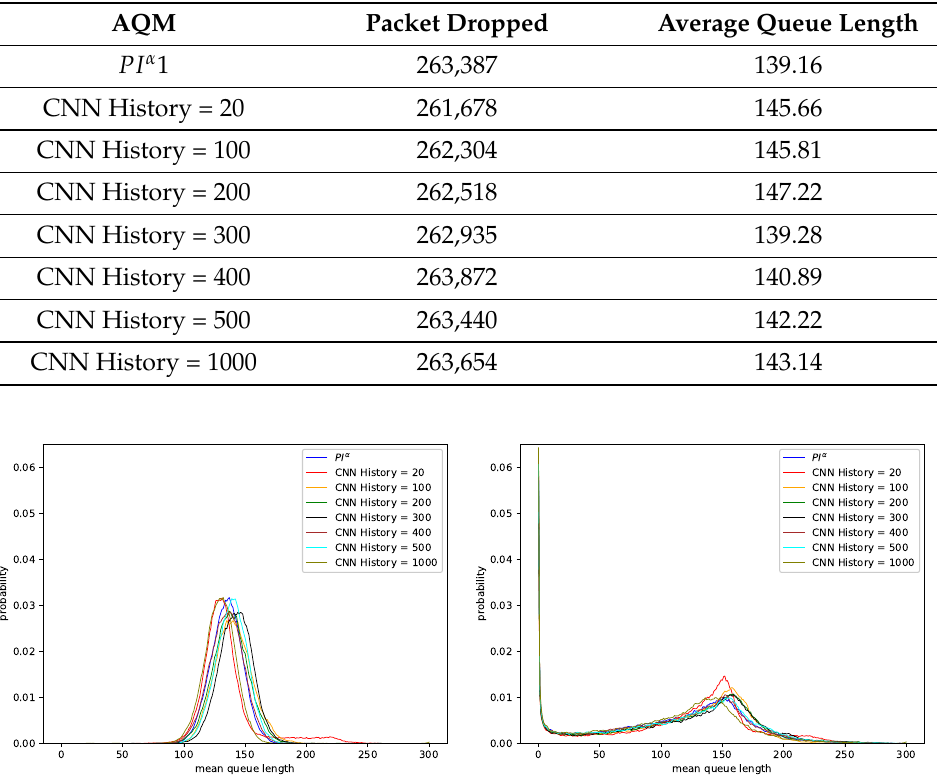
Figure 5. Distribution of queue length obtained for CNN model with the last layer activation function Sigmoid, trained using data regarding PI α 2 controller and parameters: K P = 0.0001, K I = 0.0004, α = − 0.5, H = 0.5 ( left ), H = 0.9 ( right